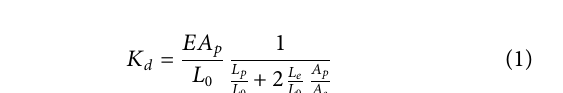
Frontiers in Built Environment |